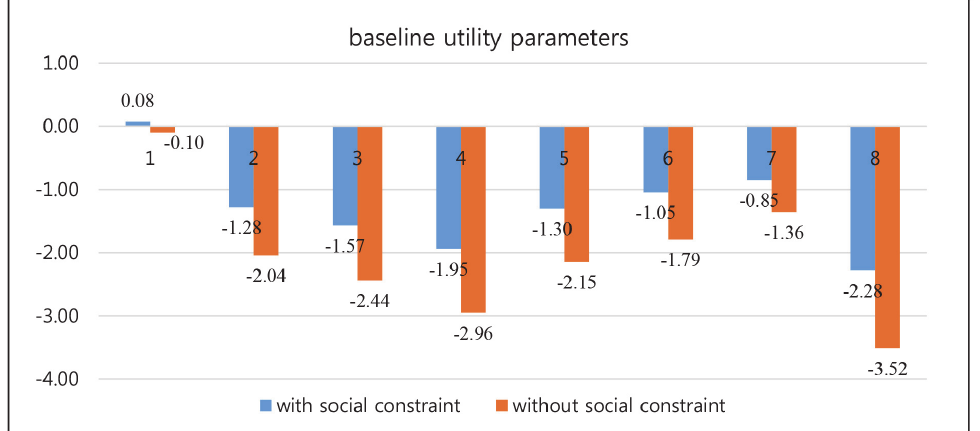
<Figure 2> Parameter Estimates(  ): Model